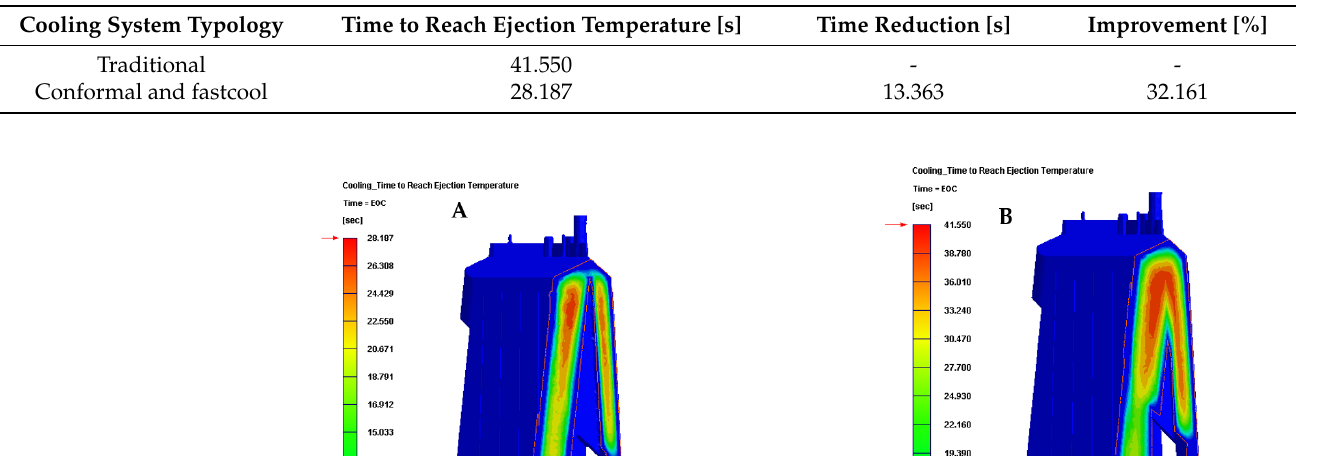
Table 7. Time to reach ejection temperature for the analyzed cooling systems.